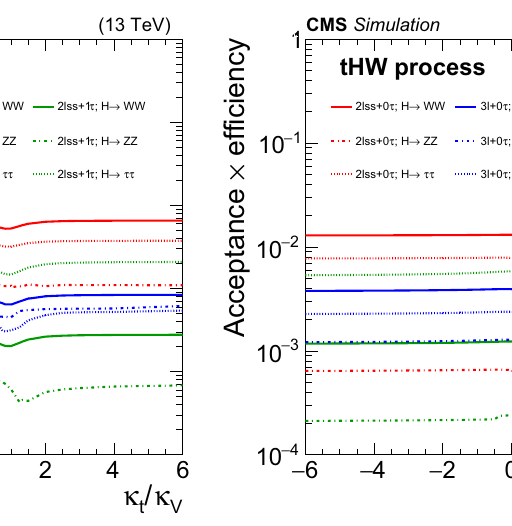
boson decay modes as a function of the ratio κ t /κ V of the Higgs boson couplings to the top quark and to the W boson